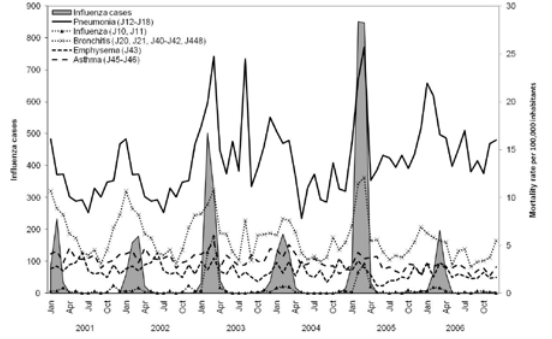
Figure 4. Influenza cases and mortality from diseases of the respiratory system in Baden-Wuerttemberg, Germany, 2001-2006.